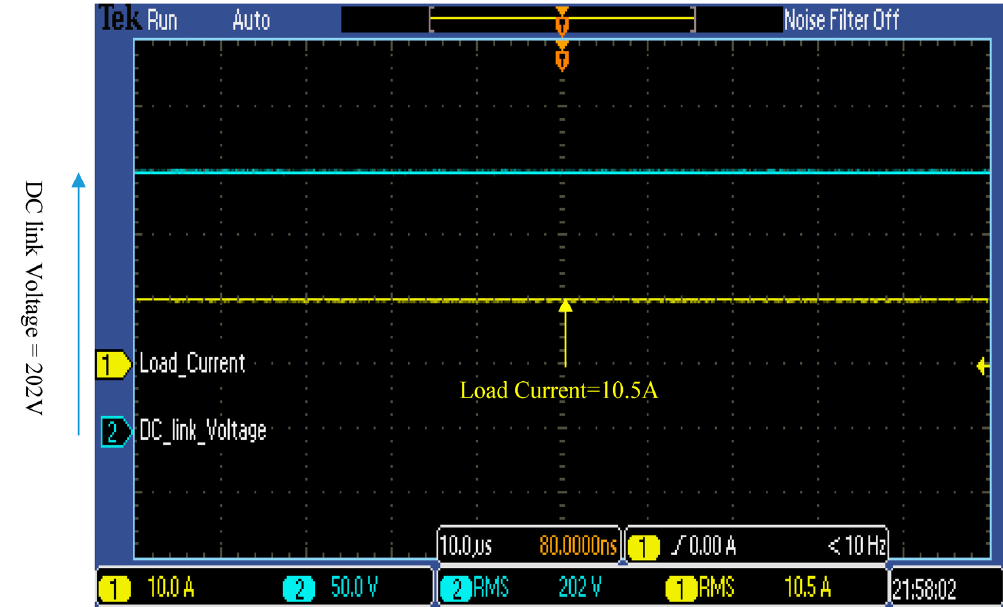
Figure 9. Experimental results of DC link voltage and load current.